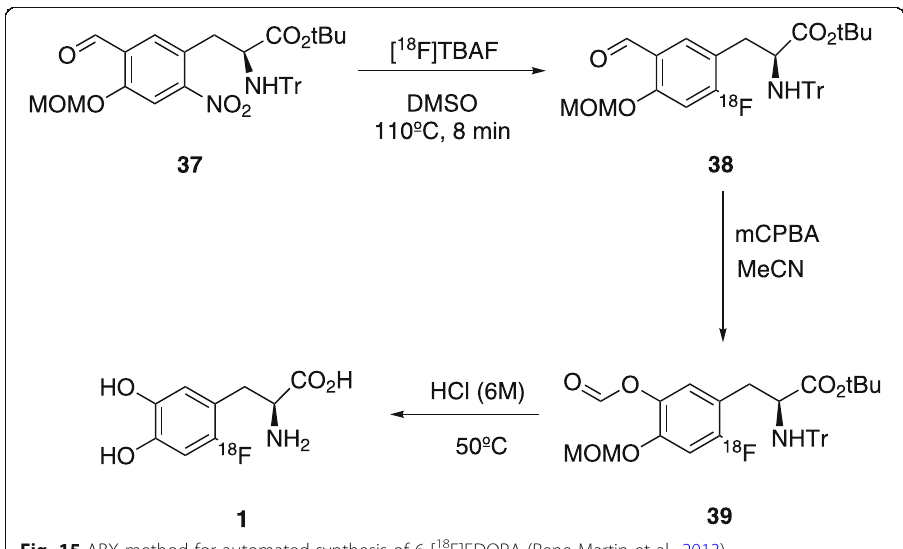
Fig. 15 ABX method for automated synthesis of 6-[ 18 F]FDOPA (Rene-Martin et al., 2013)